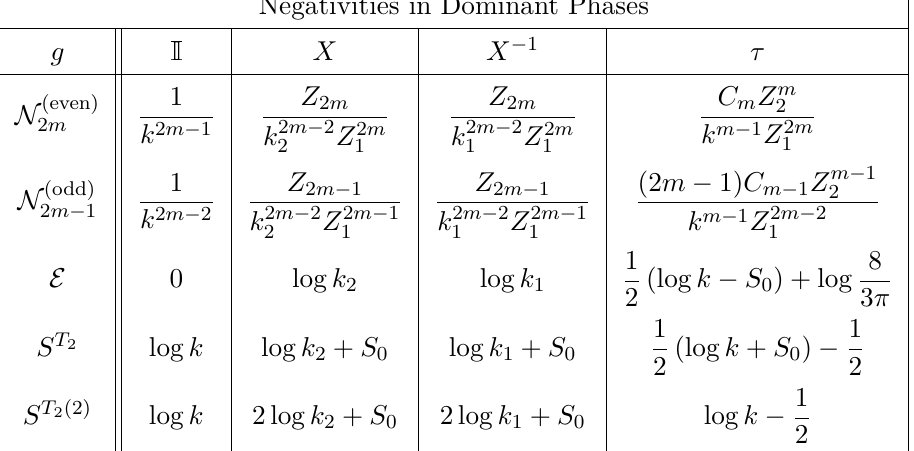
Table 1 . Top two rows: Rényi negativities in the four dominant phases labeled by the corresponding permutation g . Bottom three rows: schematic values of three special limits of the analytic continued Rényi negativities (where we have used Z n ∼ e S 0 ). Here C m = 1 which gives the number of non-crossing